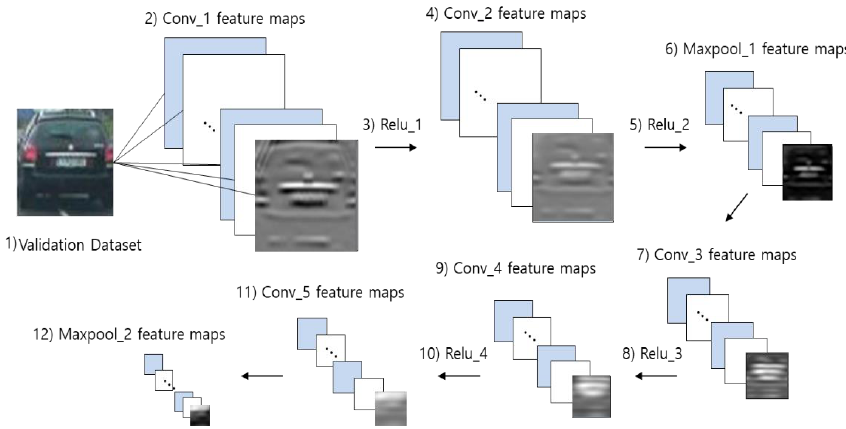
Figure 3. Proposed visualization technique for the CNN model.